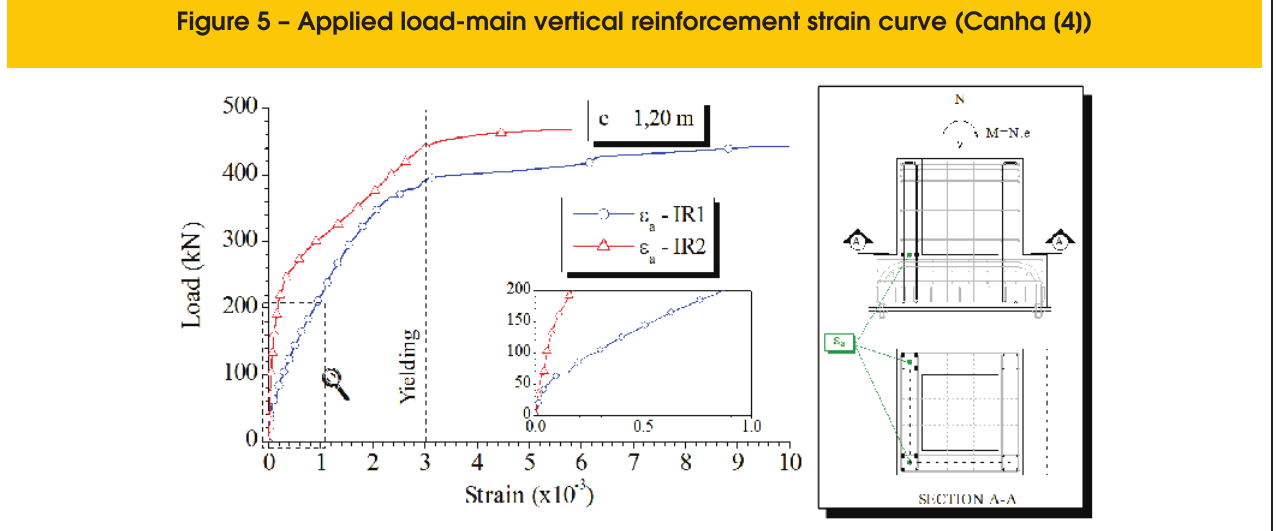
Figure 5 – Applied load-main vertical reinforcement strain curve (Canha